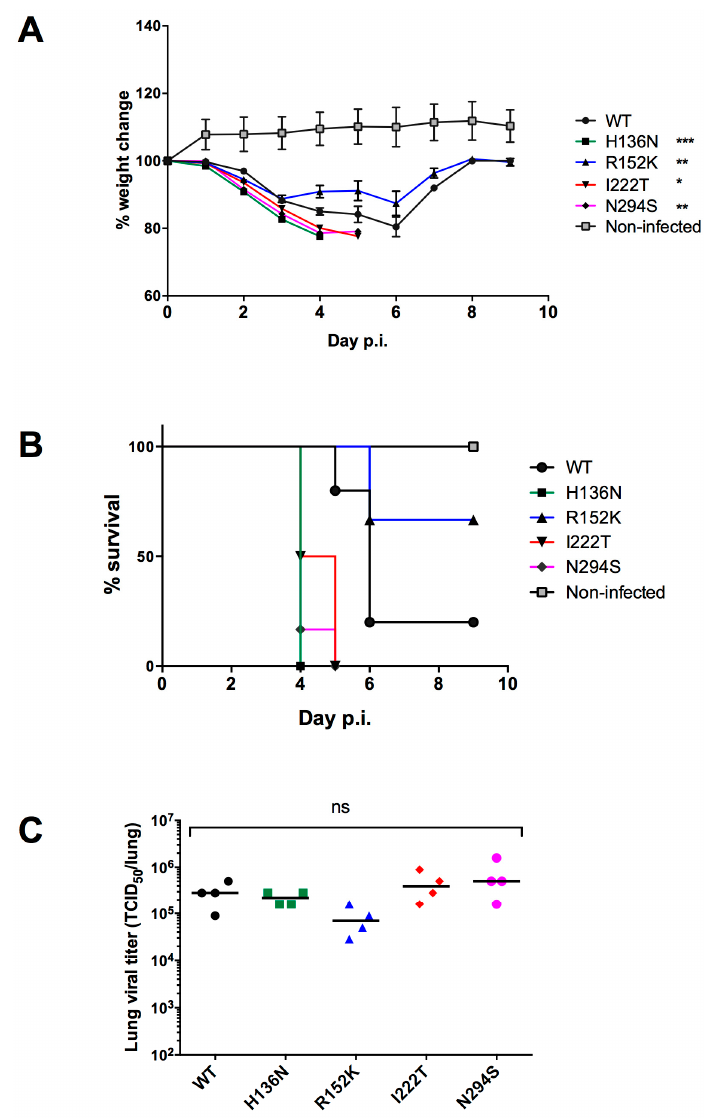
Figure 2. Virulence of recombinant IBVs with reduced susceptibility to NAIs. In each group, ten BALB/c mice were infected by the intranasal route with 5 × 10 6 PFUs of each recombinant B/Phuket/3073/2013 virus. Weight loss ( A ) and mortality ( B ) were monitored throughout the experiment. At day 3 p.i., 4 mice in each group were sacrificed and their lungs were harvested to determine lung viral titers ( C ). Statistical analyses of weight loss at day 4 (indicated in the legend) and lung titers were performed using one-way ANOVA, Dunnett’s multiple comparisons test between the WT group and each of the mutant groups. ns, not significant, *, p < 0.05 between WT and I222T, **, p < 0.01 between WT and R152K or N294S groups, ***, p < 0.001 between WT and H136N groups. For the WT group, due to a technical problem during infection, one mouse was excluded from our analysis.